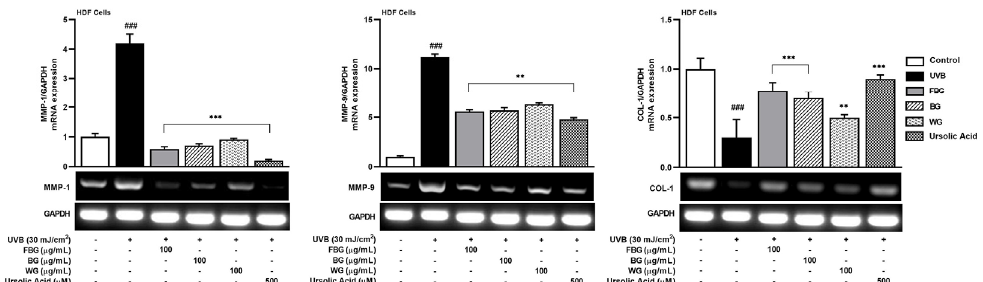
Figure 4. Effect of FBG, BG, and WG on anti-wrinkle mechanism. The HDF cells were treated with 100 µ g/mL of FBG, BG, or WG for 24 h. The expression of MMP-1, MMP-9, and COL-1 at the mRNA level was determined using qRT-PCR. Ursolic acid (500 µ M) was used as a positive control. The graph shows mean ± SD values of three replicates. ### p < 0.001, as compared with the control group; ** p < 0.01, *** p < 0.001, as compared with the UVB-irradiated group.